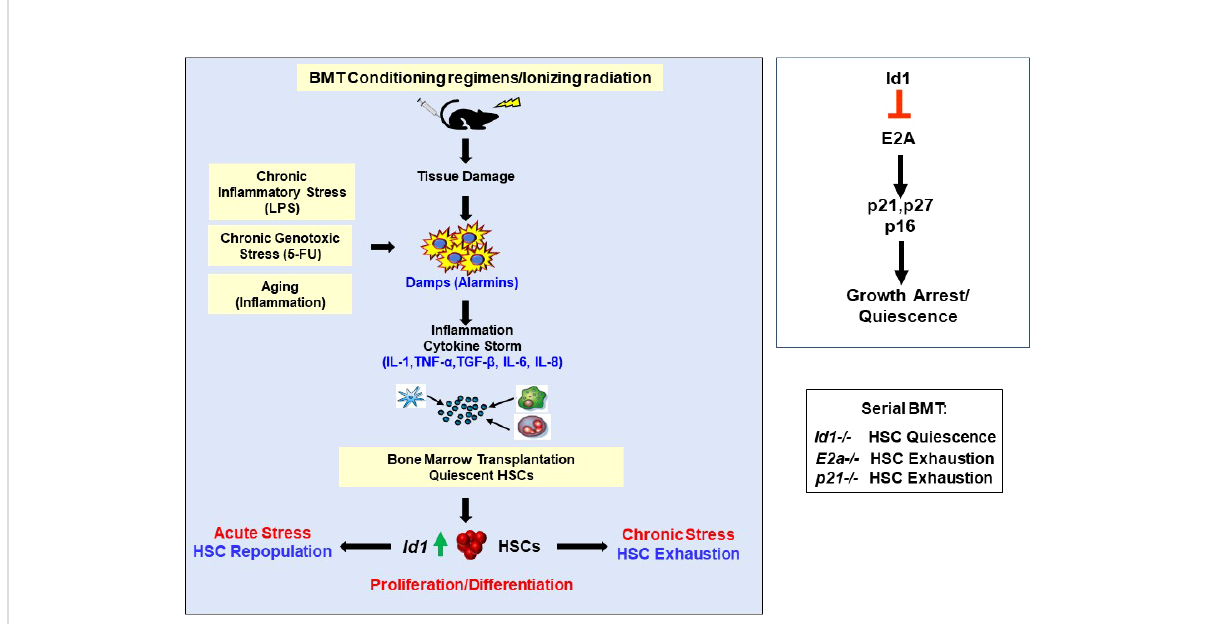
FIGURE 4 Ablation of Id1 Protects HSCs from chronic proliferative stress including BMT, chronic genotoxic and in fl ammatory stress, and aging. Summary of mechanism of ID1 action in HSCs, and gene knockout mouse models in the molecular